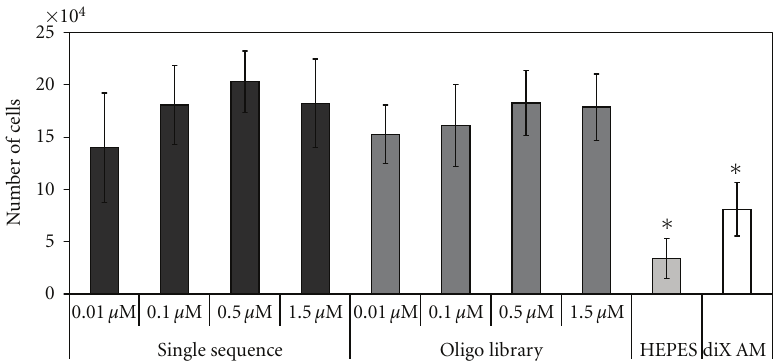
Figure 8: Incubation of eEPC cells on diX AM surfaces with di ff erent amounts of oligonucleotides. Amount of oligonucleotides did not significantly influence cell adhesion ( F (7,16) = 1 . 598; P = 0,207). Groups marked with ∗ are significantly di ff erent to all oligonucleotide coated samples ( P < 0 . 05, n = 3).